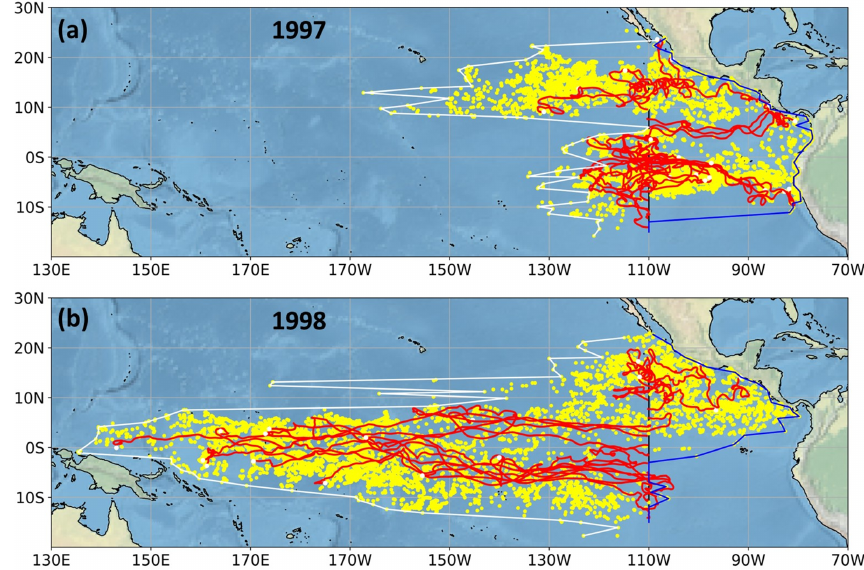
Figure 1. The final positions of passively advected parcels (yellow dots) after 365d. Start date: (a) 1 January 1997 (a particularly strong El Niño year) and (b) 1 January 1998. The initial positions of the 6600 tracers were along a meridional line at longitude 110 ◦ W and between latitudes 15 ◦ S–15 ◦ N (black vertical line on the maps). The white/blue lines indicate the western/eastern envelopes of the tracer clouds after 1 year of advection, while red lines exhibit representative trajectories. The flow fields are from the AVISO data bank (Aviso, 2022; Taburet et al.,